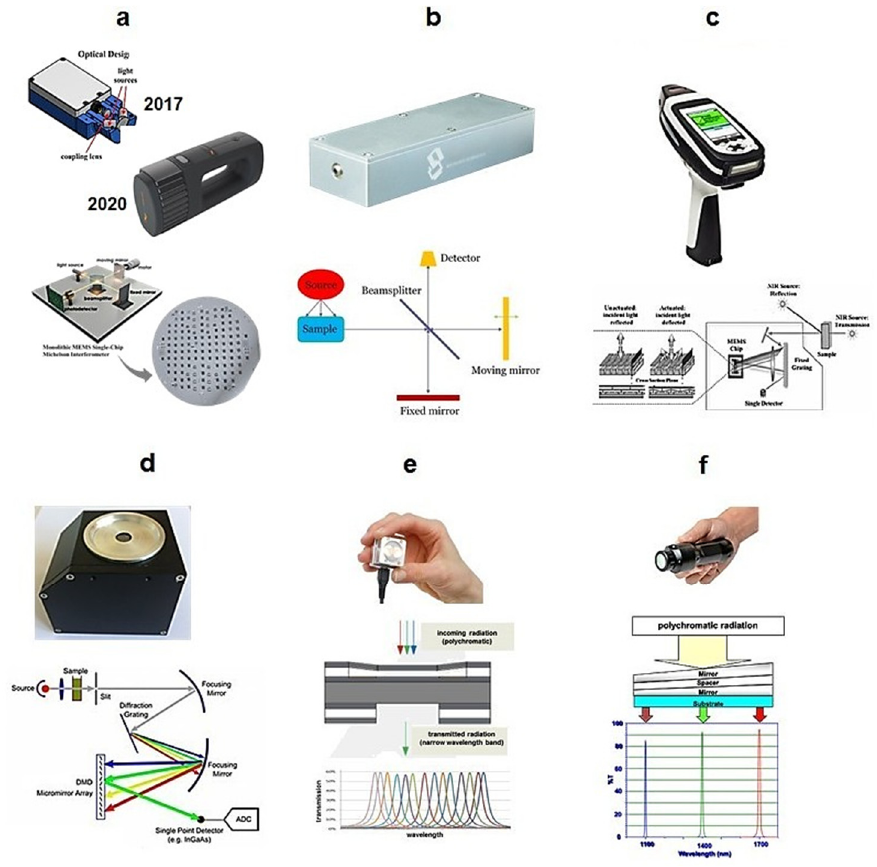
Figure 4. Principles of wavelength selectors built into different handheld NIR spectrometers: ( a )